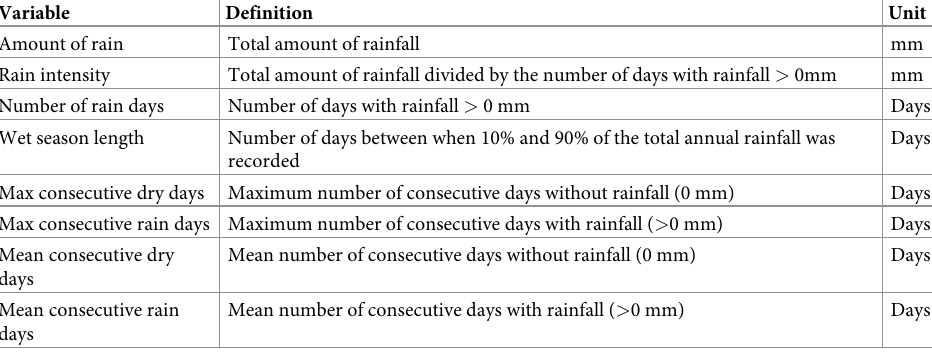
Table 2. Rainfall variables used to examine the relationship between growth of Callitris columellaris and rainfall amount, intensity, frequency, and